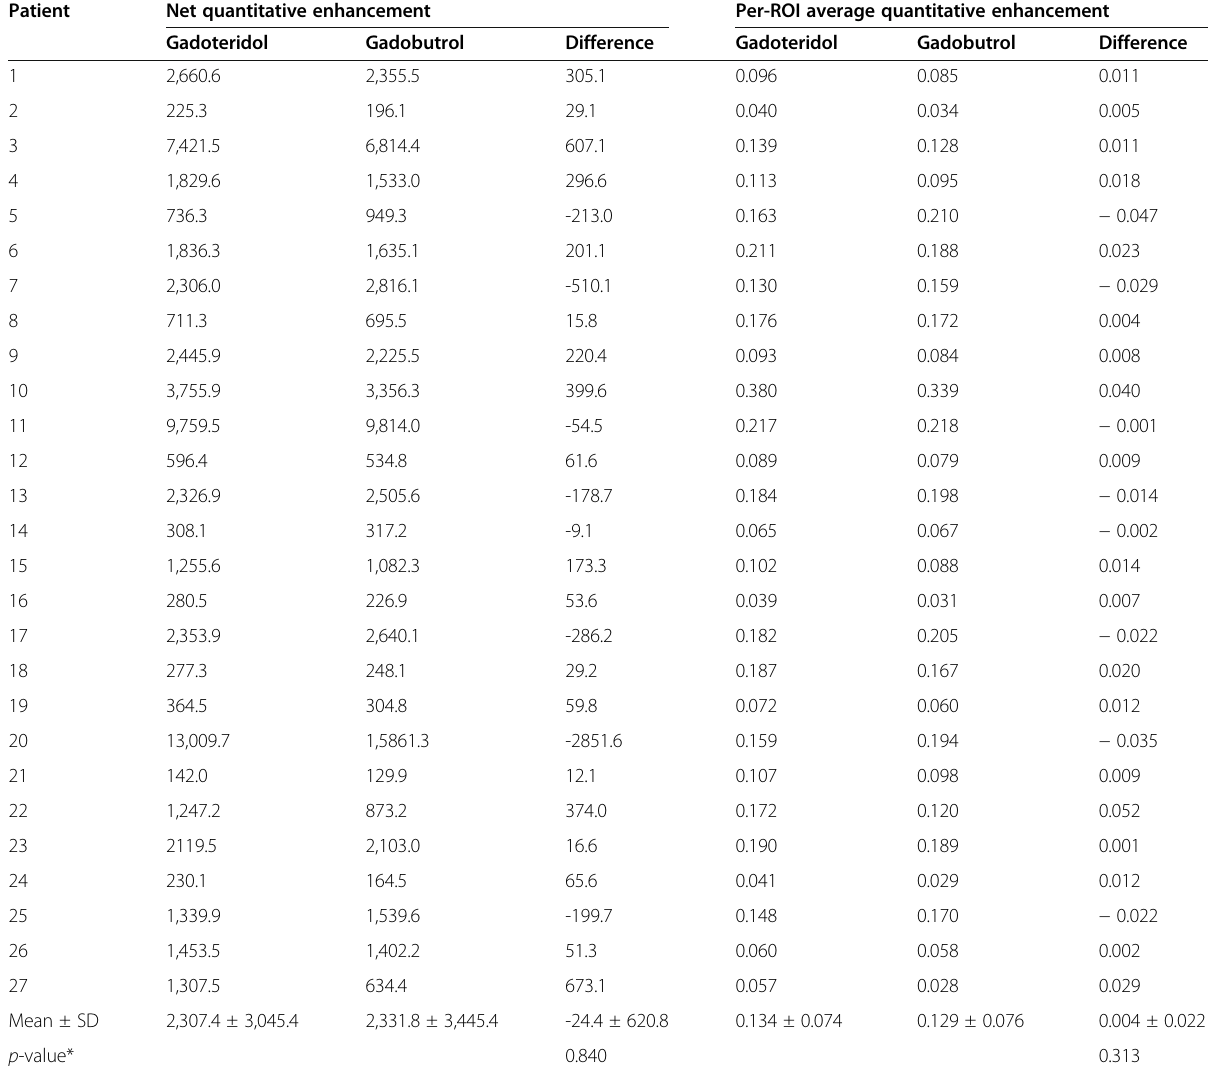
Table 1 Net quantitative enhancement and per-region of interest (per-ROI) average quantitative enhancement for 27 patients with histologically confirmed glioblastoma from the TRUTH study [18]